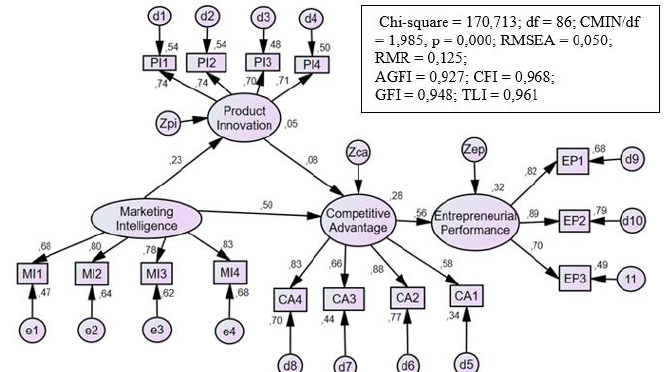
Figure 2: Initial Research Model